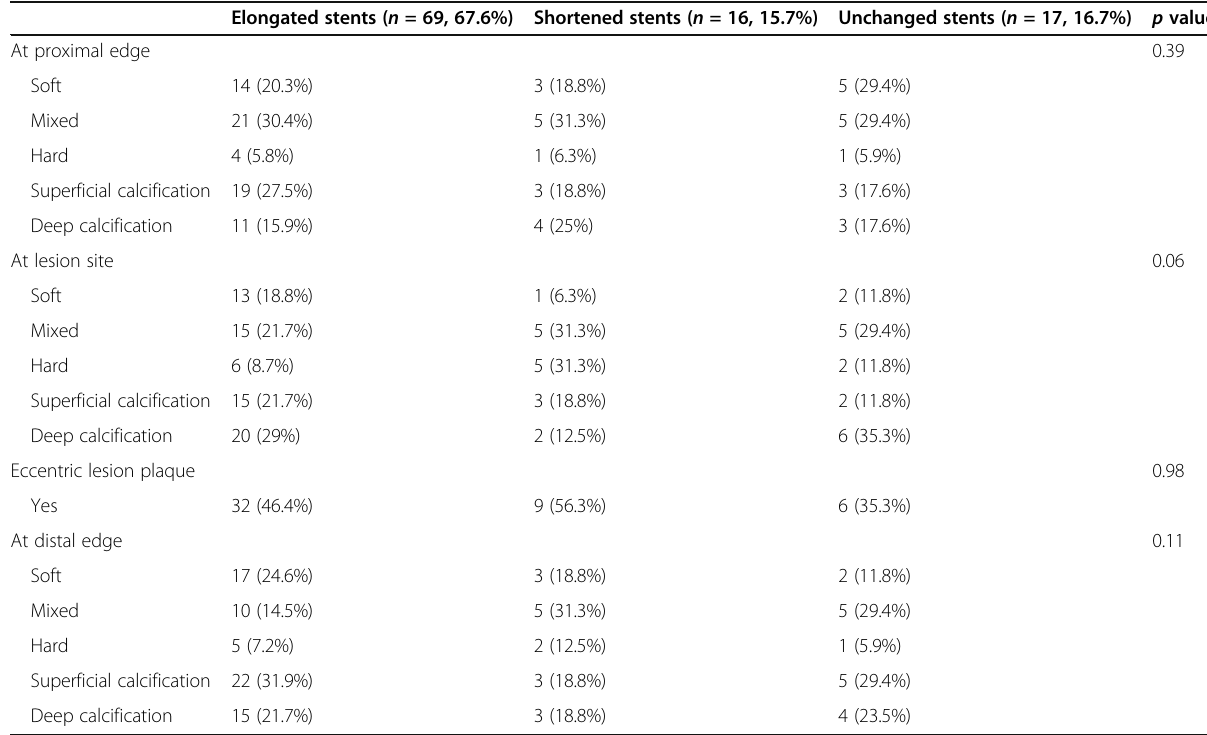
Table 3 IVUS plaque-media type by